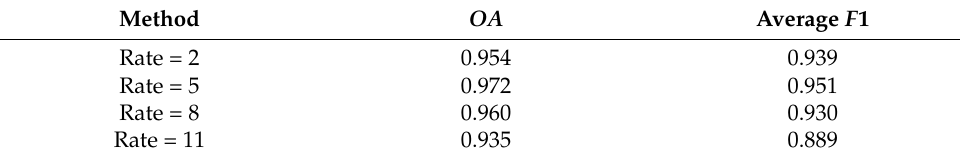
Table 6. Comparison of different dilation rates of atrous